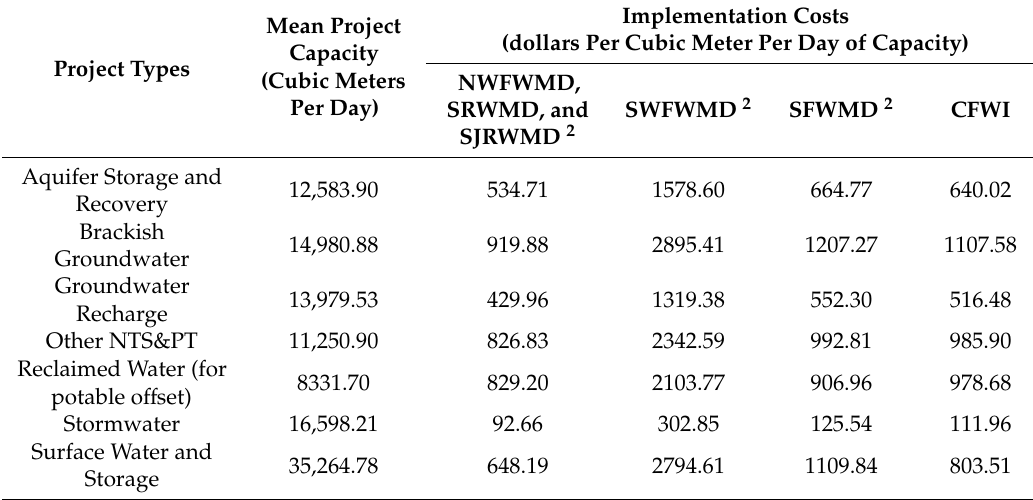
Table 7. Estimated implementation costs, assuming mean projects capacity.